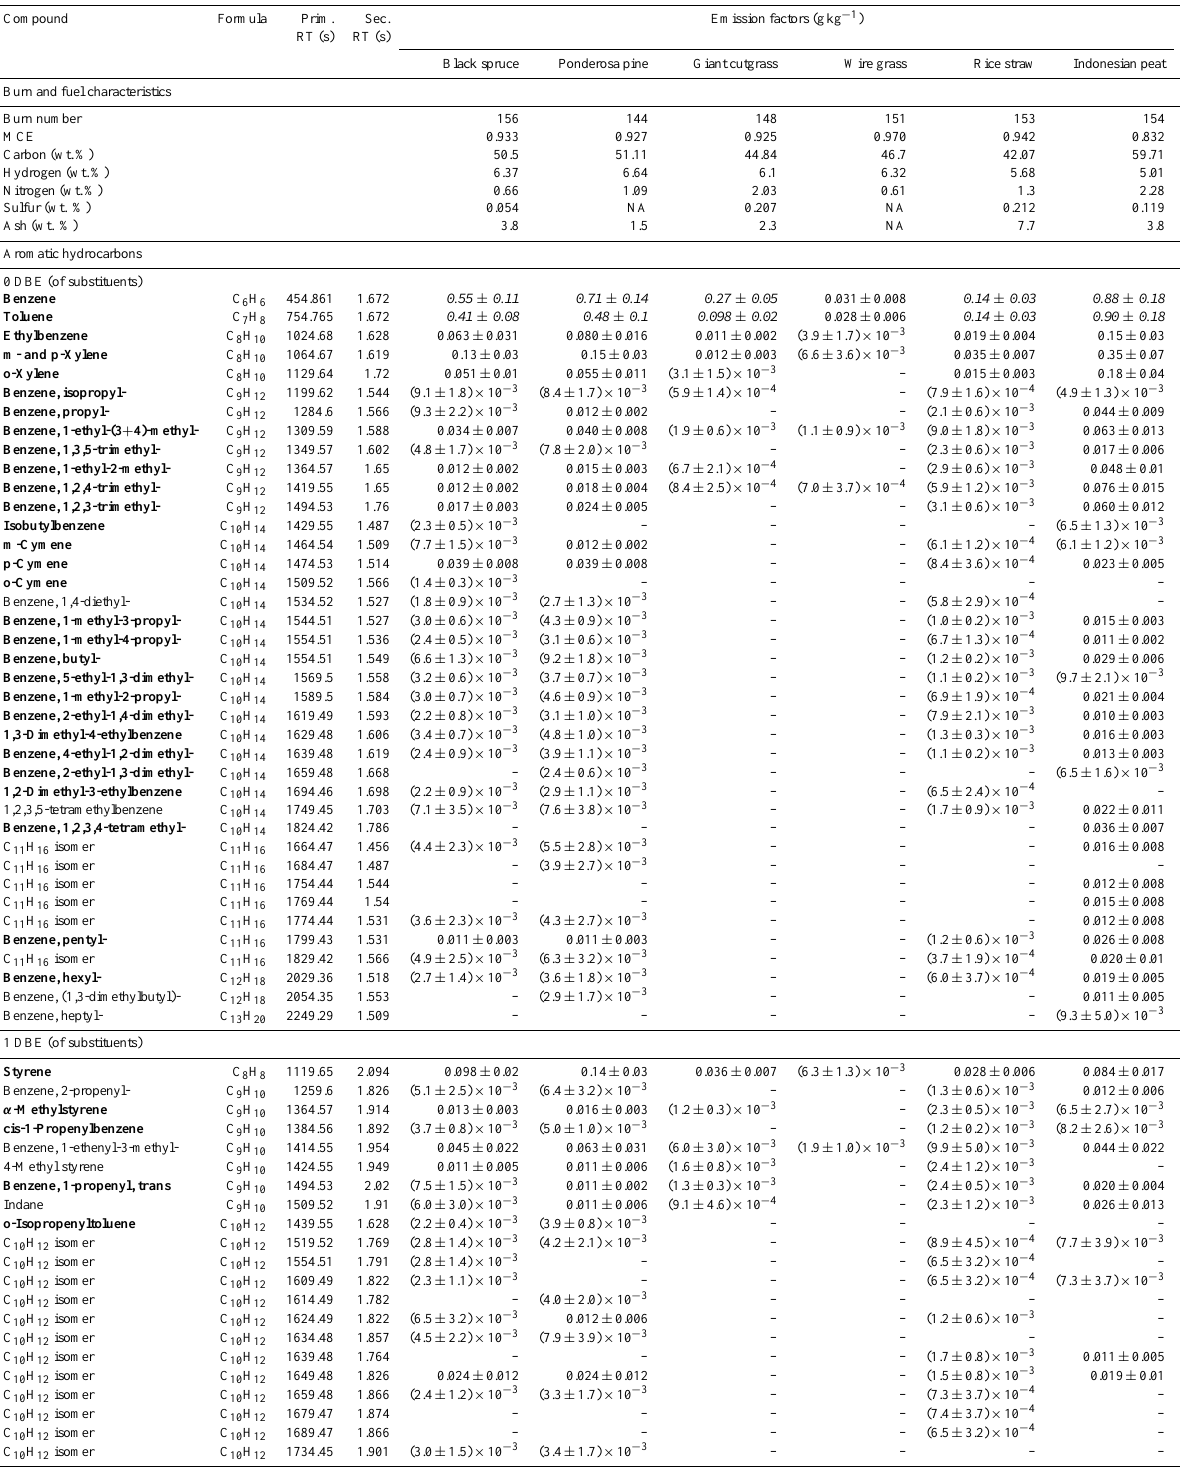
Table A1. EF for all compounds detected in the cartridge samples. Compounds in bold were positively identified. Values in italics reflect measurements that are likely